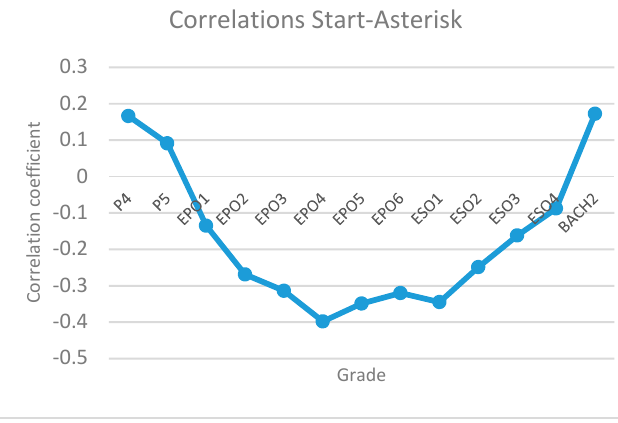
Figure 5. Start level–asterisk level correlation per school grade.